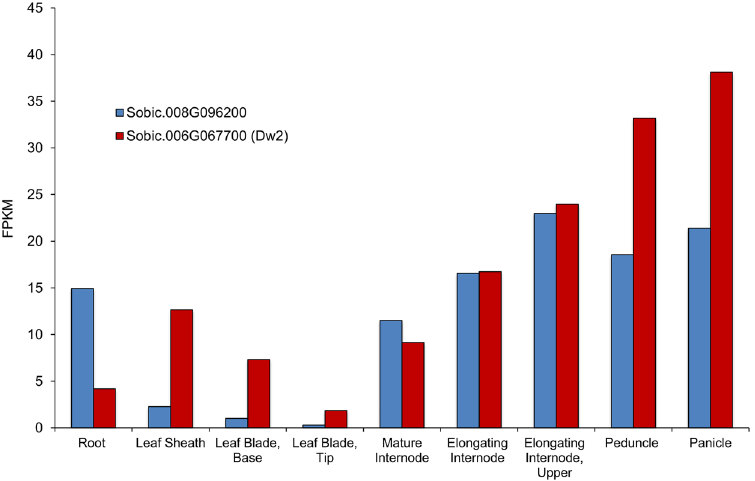
Figure 5. Expression of Dw2 and Sobic.008G096200 in various tissues. Gene expression data is from the publicly available RNA-seq GeneAtlas on Phytozome v11. Tissues are from BTx623 (dominant Dw2 ) at 44 Days after Emergence (DAE). The leaf tissue was taken from the last ligulated leaf, so the base is still growing whereas the tip is